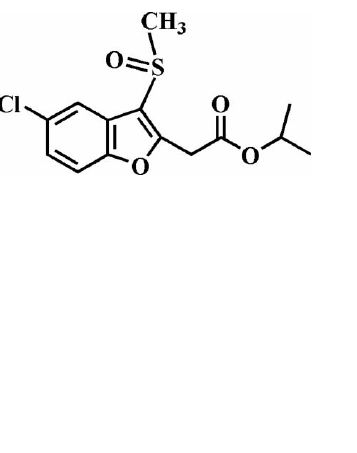
ORTEP-3 (Farrugia, 1997) and DIAMOND (Brandenburg, 1998); software used to prepare material for publication: SHELXL97